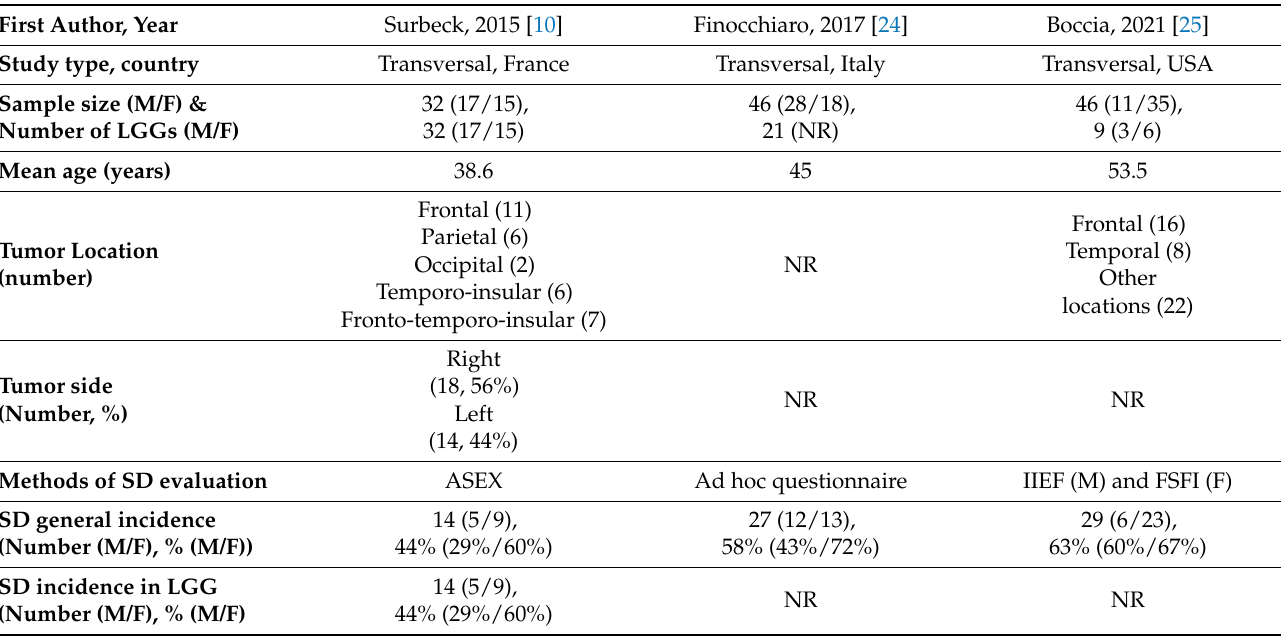
Table 1. Incidence of SD and repercussions on QoL in studies considering brain tumors including LGG